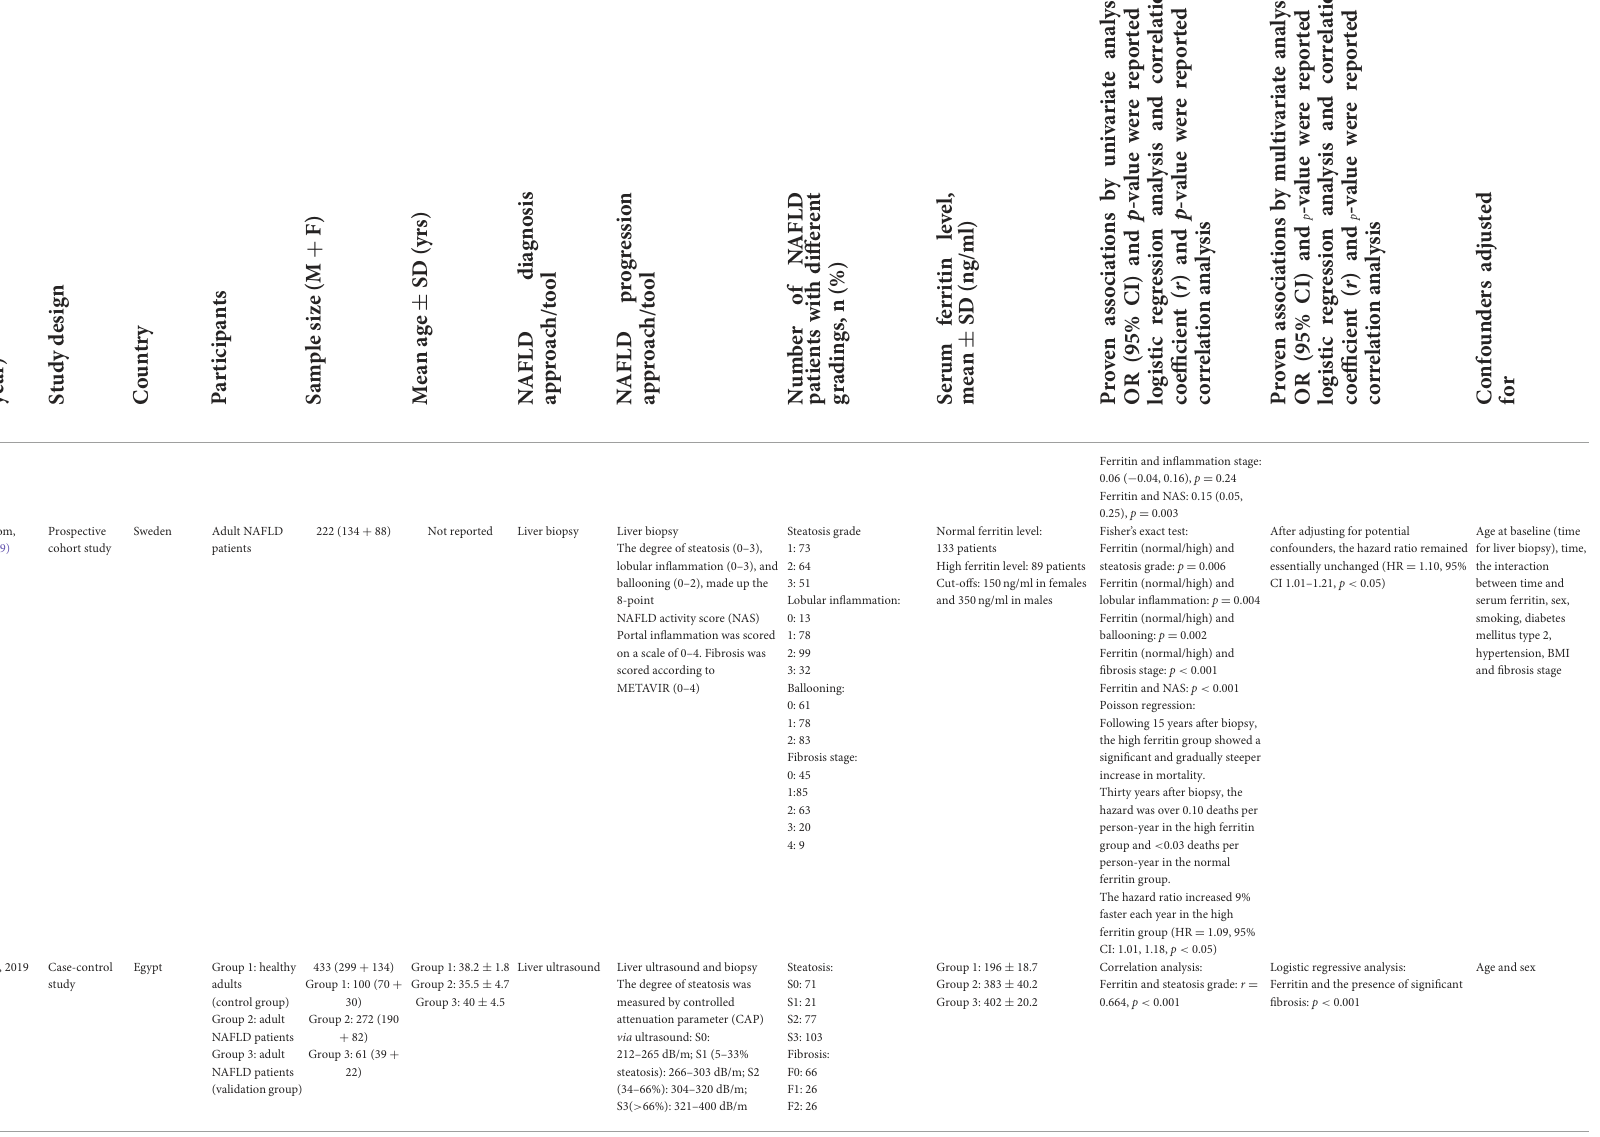
increaseinmortality. Thirtyyearsafterbiopsy,the hazardwasover0.10deathsper person-yearinthehighferritin groupand < 0.03deathsper person-yearinthenormal ferritingroup. Thehazardratioincreased9% fastereachyearinthehigh ferritingroup(HR = 1.09,95% CI:1.01,1.18, p < 0.05)